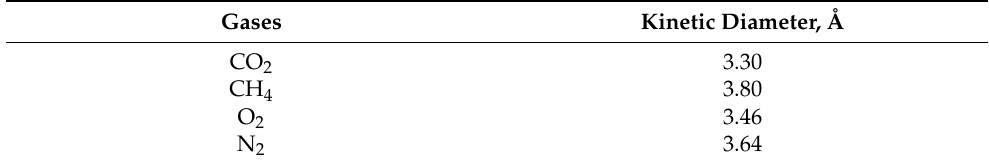
Table 5. Kinetic diameters for different gases [69].